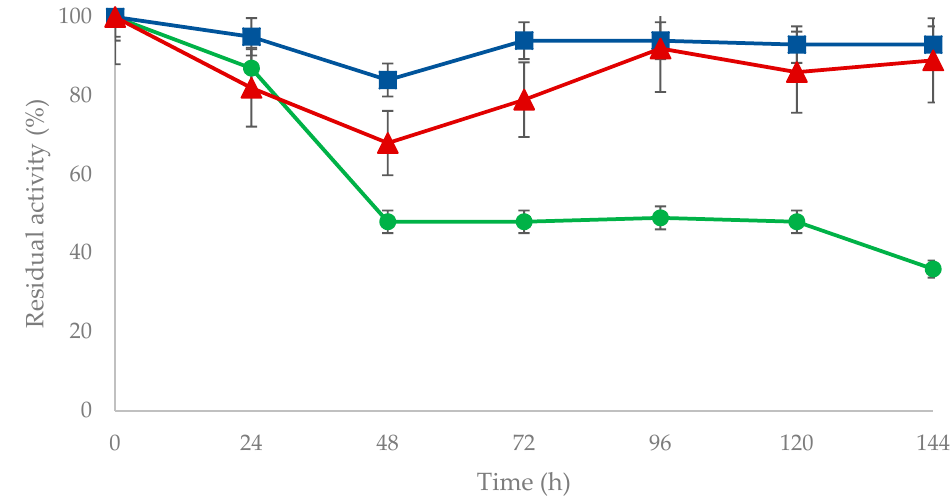
Figure 2. Stability of soluble OYE3 (green circles), OYE3-GA (blue squares) and OYE3-EziG (red triangles). Experimental conditions: 50 mM phosphate buffer pH 7 (1% DMSO), ( R )-carvone and NADH = 1 mM, 28 °C, volume = 1 mL.